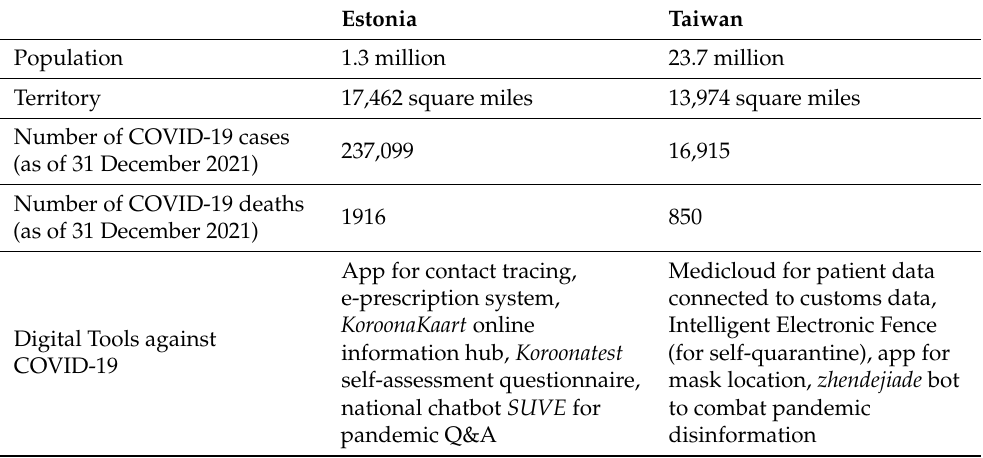
Table 1. Digital Tools and COVID-19 Outcomes in Estonia and Taiwan: A Summary of the